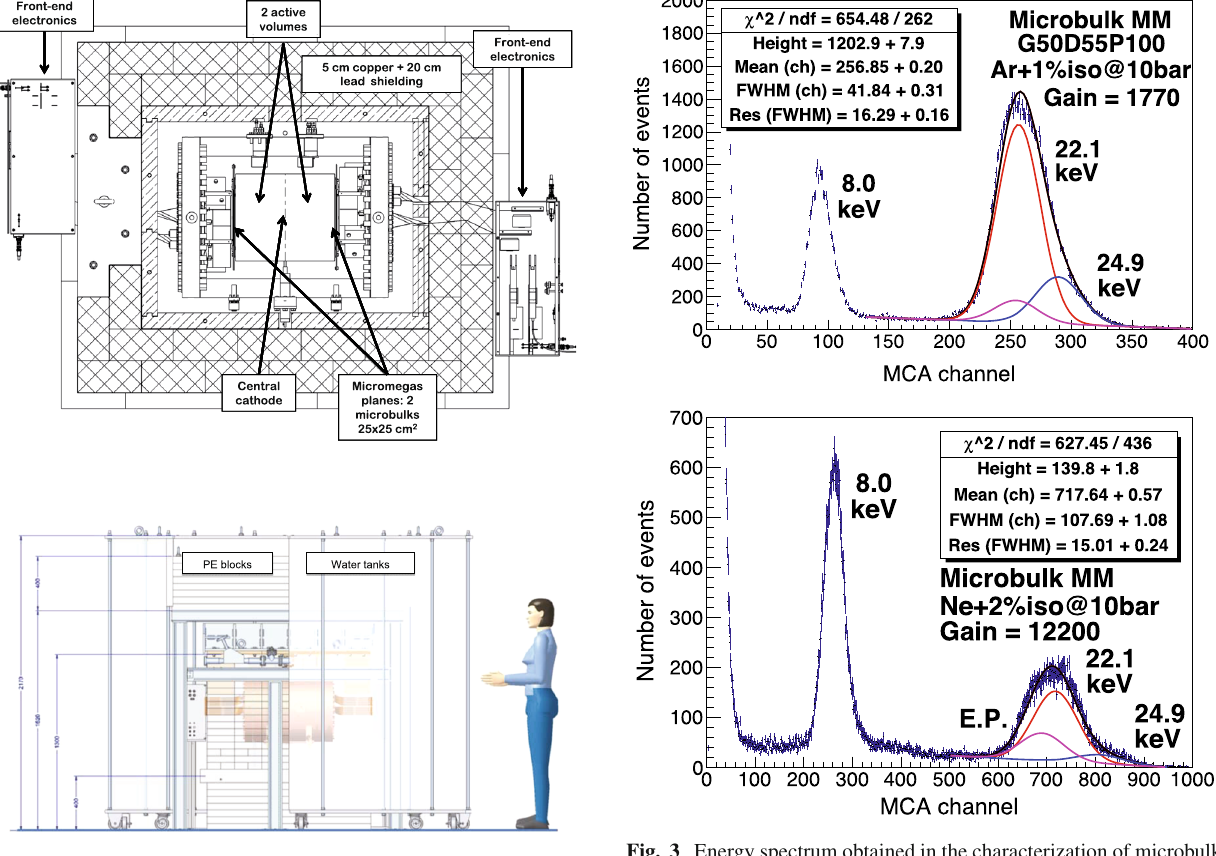
Fig. 2 Top view of the design of the copper and lead shielding (top) and side view of the moderator shielding (bottom) for TREX-DM at LSC